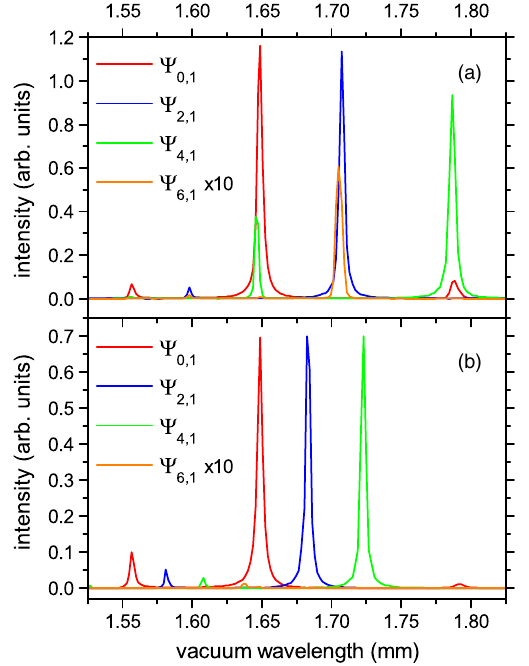
FIG. 6. The spectral density distributions of the Ψ 0 and Ψ 6 modes plotted at δ L ¼ − 38 mm for z ; 1 2 . 3 m (b). The distributions are normalized with respect to z R ¼ the pulse energy.